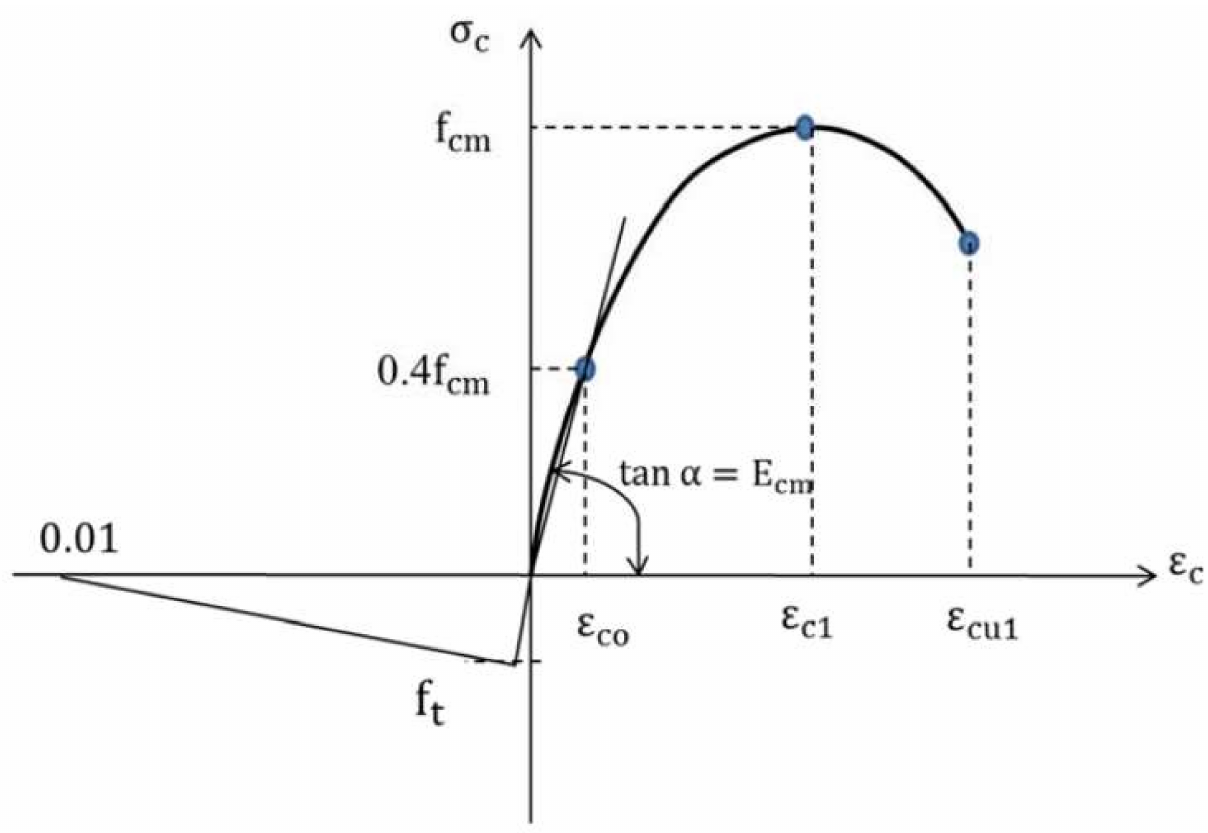
Figure 11. Stress–strain relation for concrete.